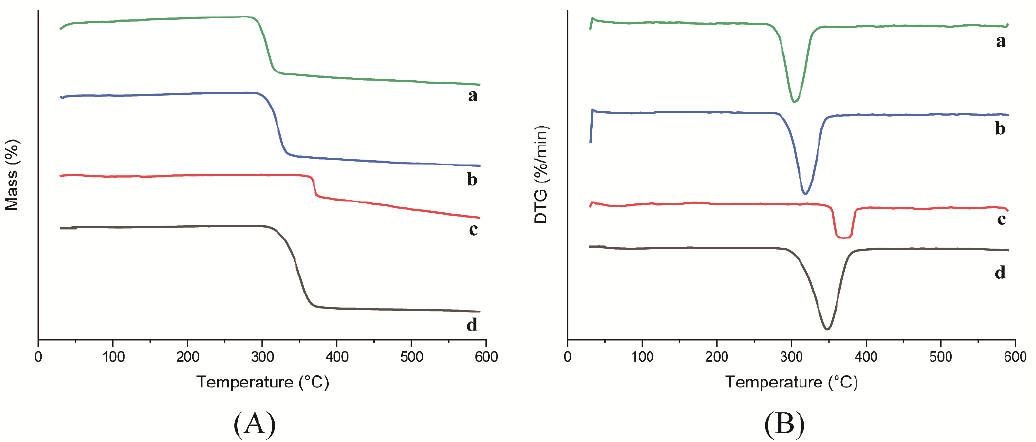
Figure 5 TG ( A ) and DTG ( B ) curves of HP-β-CD: myricetin inclusion complex (a), HP-β-CD: Figure 5. TG ( A ) and DTG ( B ) curves of HP- β -CD: myricetin inclusion complex (a), HP- β -CD: myricetin physical mixture (b), myricetin (c) and HP- β -CD